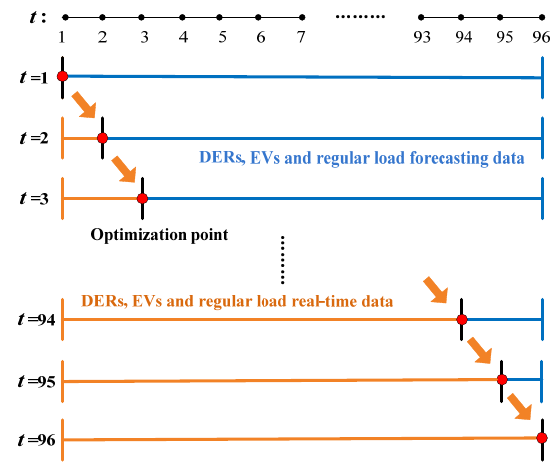
Figure 3. Framework of real-time